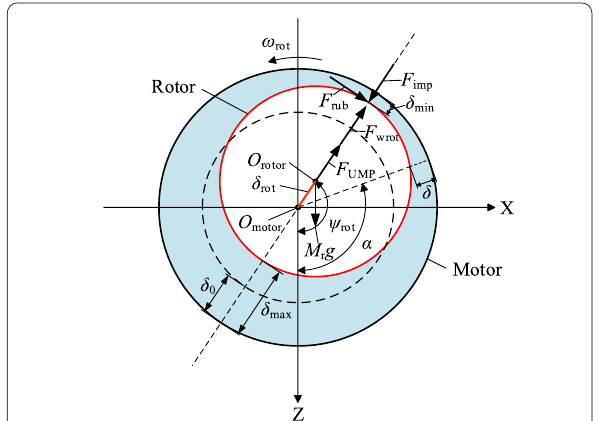
Figure 5 Schematic of the rotor